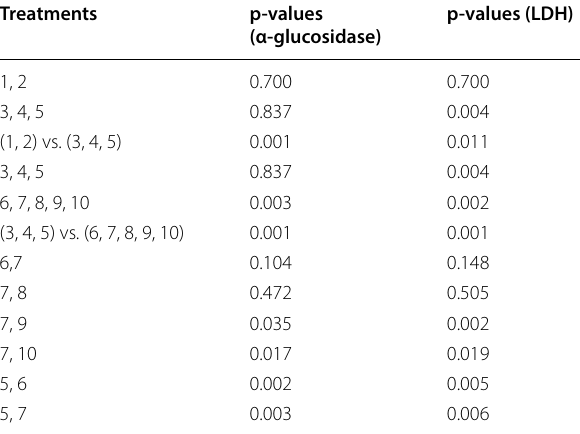
Table 1 P-values